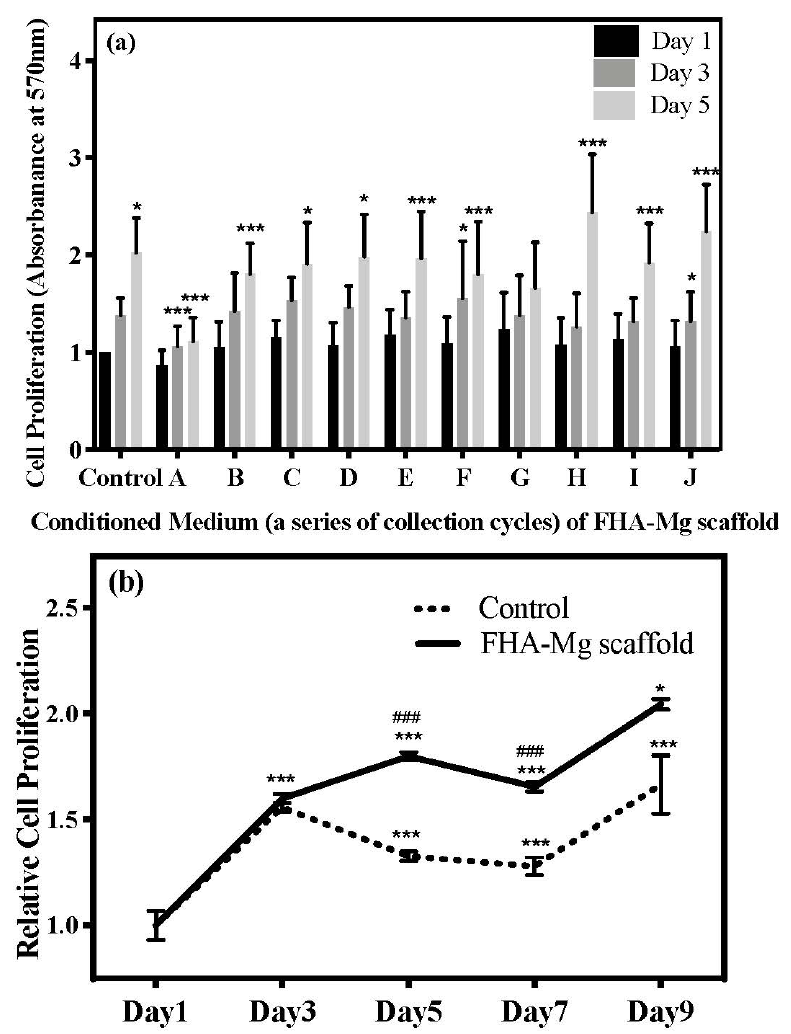
Figure 6. ( a ) AlamarBlue ® assay of hMSC proliferation on a culture dish in the conditioned media collected from FHA-Mg scaffolds at sequential time points. hMSCs cultured on a culture dish in maintenance culture medium were the control group. Values shown are mean ± standard error ( n =